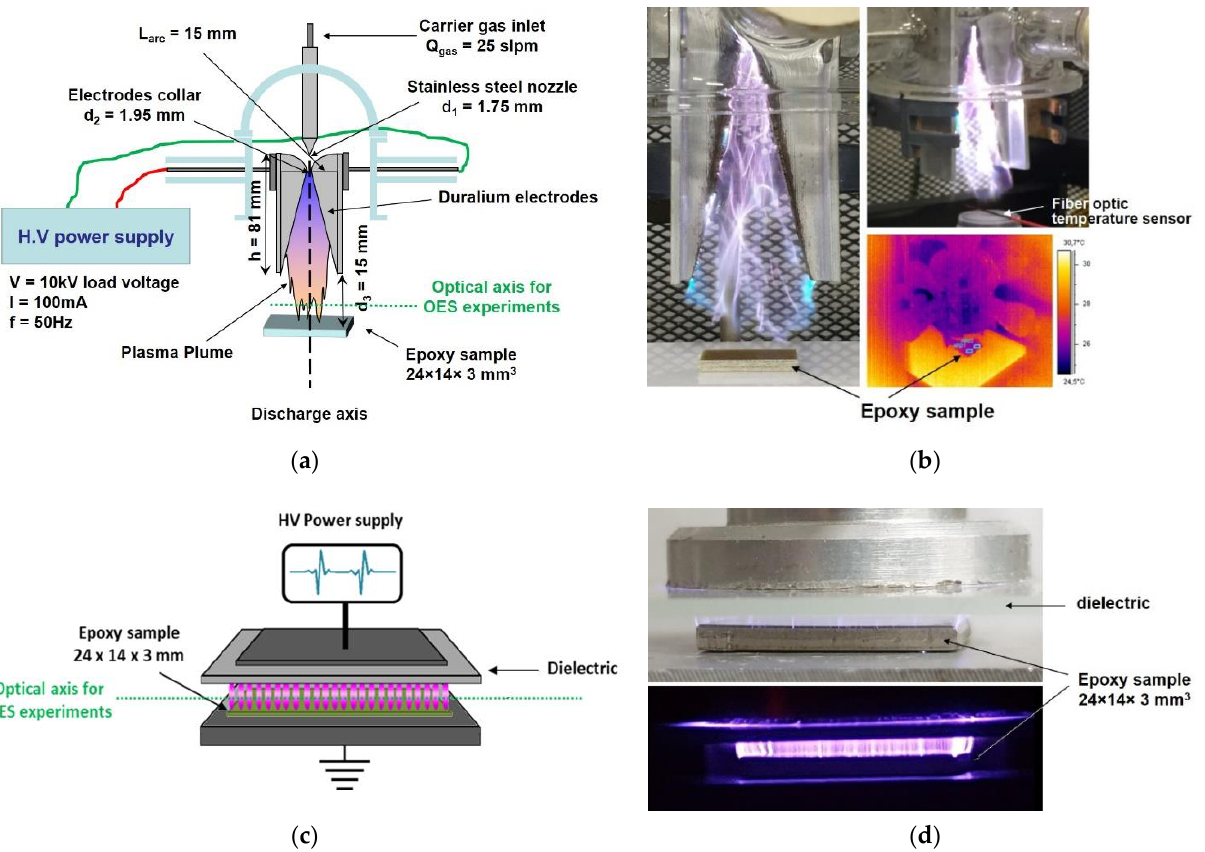
Figure 1. Schematics of the reactor configurations used in this study: ( a , b ) Gliding Arc plasma reactor and ( c , d ) Parallel-plate, open-air DBD plasma reactor.